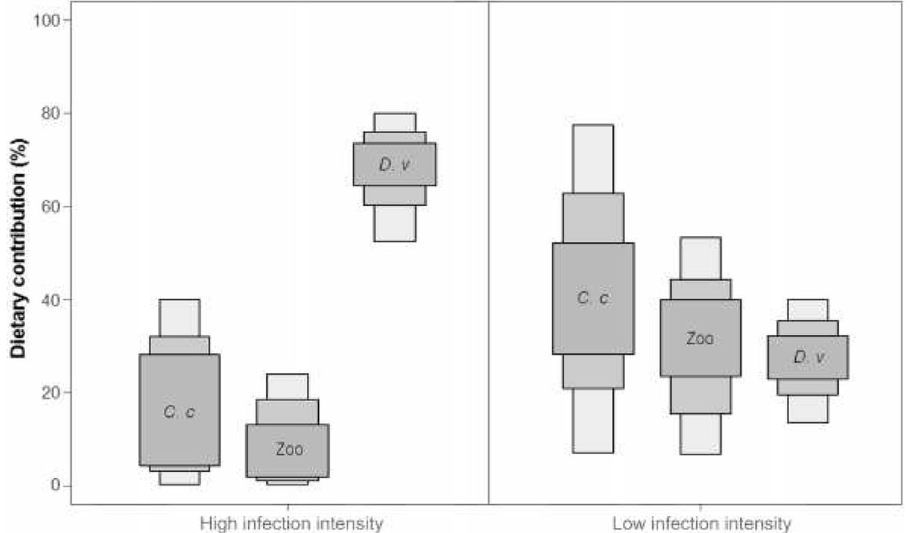
Figure 5. Result of SIAR Bayesian mixing model, based on δ 13 C and δ 15 N signatures, showing estimated contributions (%) of Chelicorophium curvispinum (C.c), zooplankton (Zoo) and Dikerogammarus villosus (D.v) to the diet of YOY perch ( Perca fluviatilis ) with different eye fluke infection intensity at the northern shore of Lake Müggelsee in 2016. Low infection intensity = 5 ± 3 metacercariae per fish (average ± SD) and high infection intensity = 39 ± 13 metacercariae per fish (average ± SD). The plot shows 25% (inner box), 75% and 95% (outer boxes) credibility